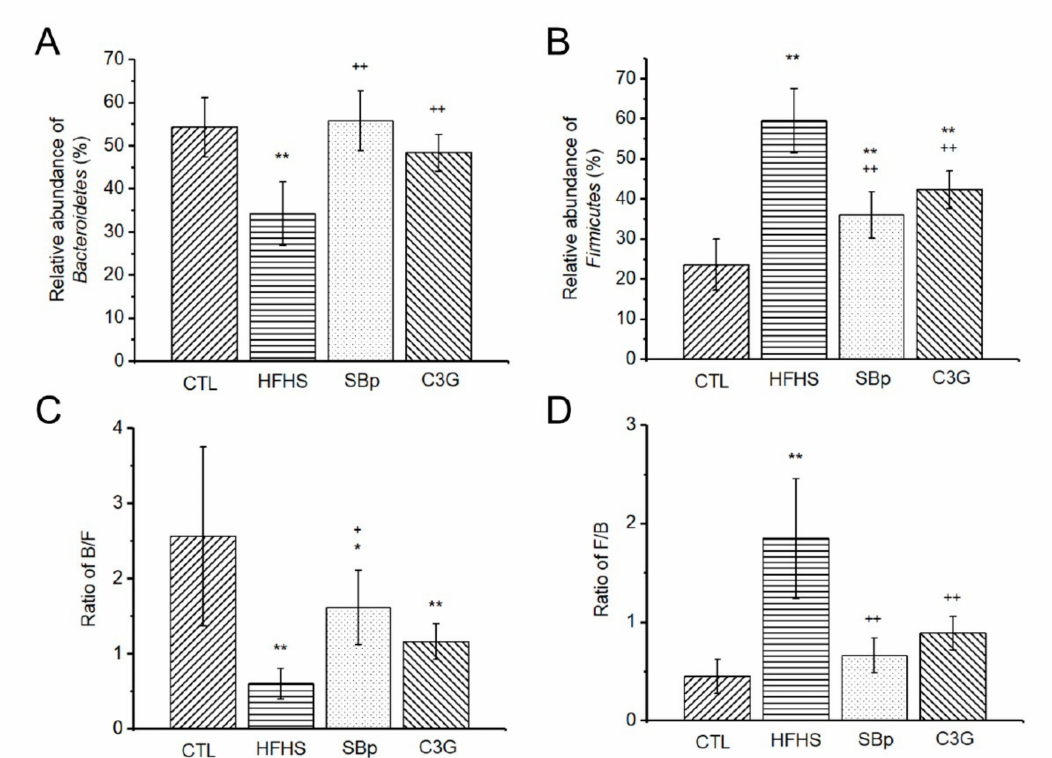
Figure 6. E ff ects of HFHS diet supplemented with or without the relative abundance of Bacteroidetes and Firmicutes and their ratios. The experimental regimen was described in the legend of Figure 1. ( A ) Relative abundance (%) of Bacteroidetes in gut microbial composition. ( B ) Relative abundance (%) of Firmicutes in gut microbial composition. ( C ) Ratio of Bacteroidetes over Firmicutes (B / F) in gut microbiota. ( D ) Ratio of Firmicutes over Bacteroidetes (F / B) in gut microbiota. Values are expressed as mean ± SD (%) ( n = 8 / group). *, **: p < 0.05 or 0.01 versus the control (CTL) group; + , ++ : p < 0.05 or 0.01 versus the HFHS